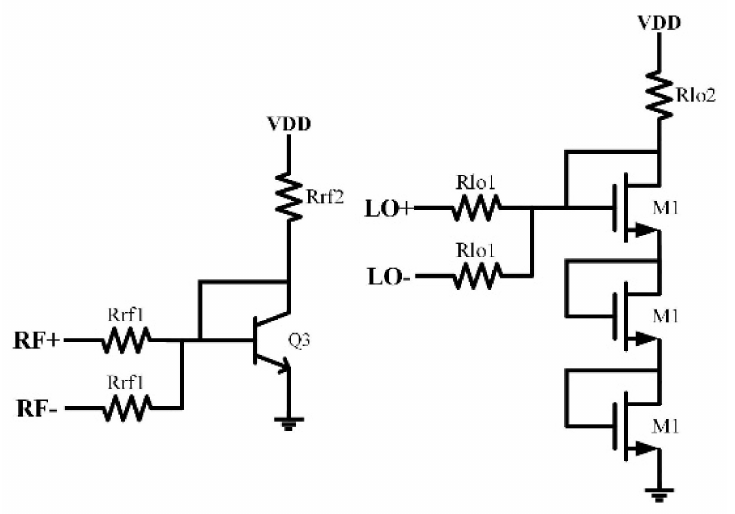
Figure 10. Schematic of the bias